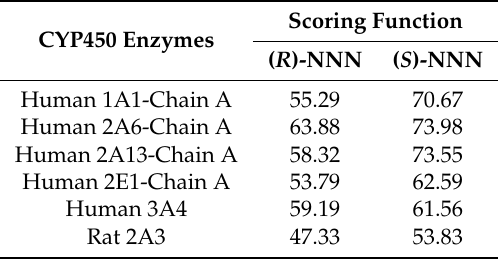
Table 2. Docking scores of ( R )- or ( S )-NNN with CYP450